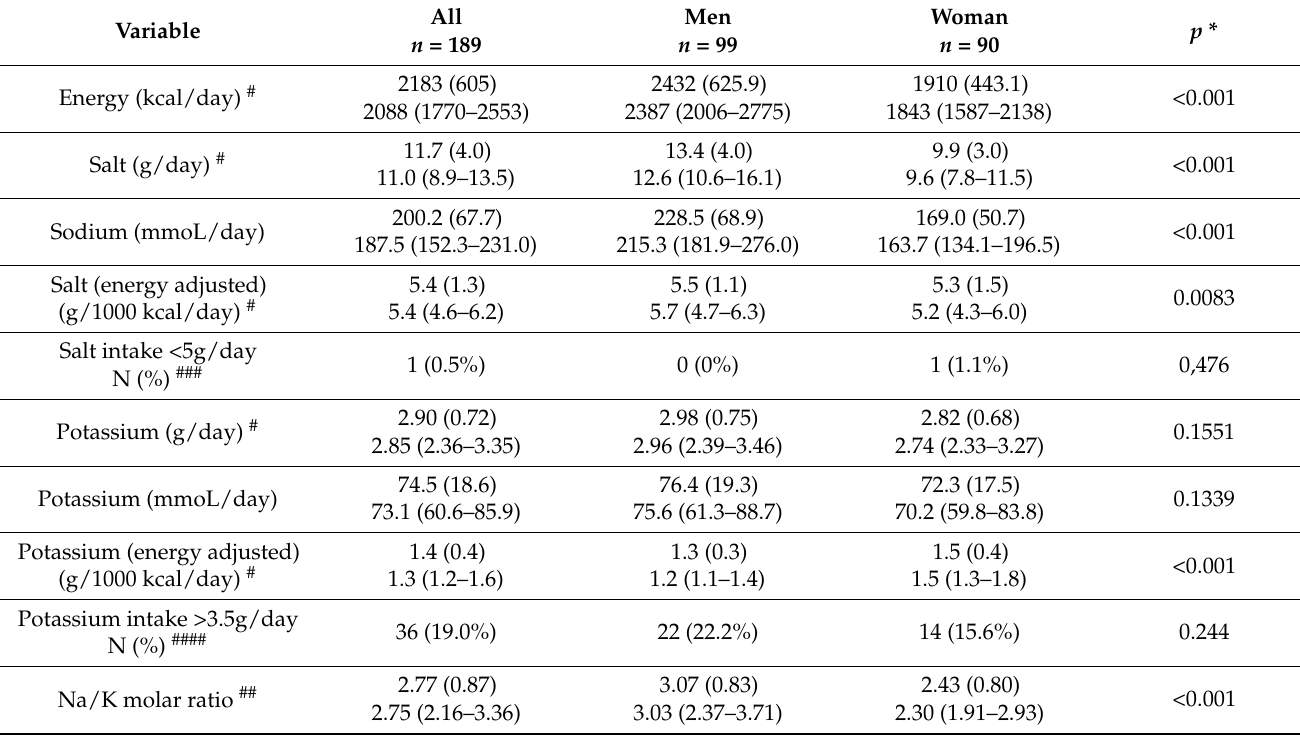
Table 3. Energy, salt and potassium intakes from three-day dietary records and the proportion of participants meeting recommended targets for salt and potassium intake, Biomarker2019